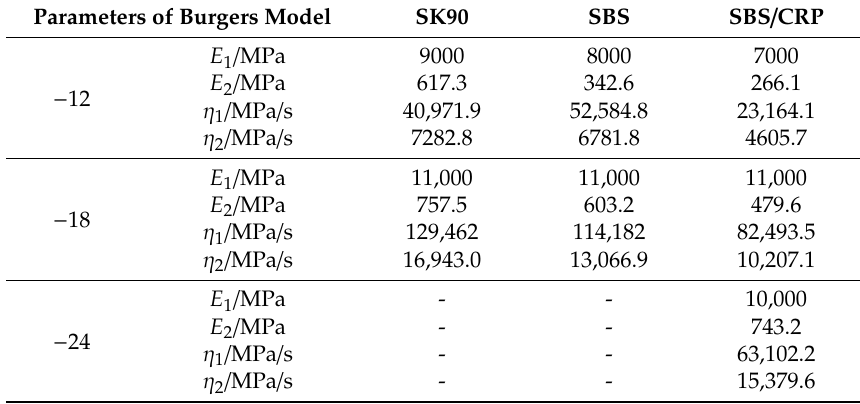
Table 6. Parameters of Burgers model.